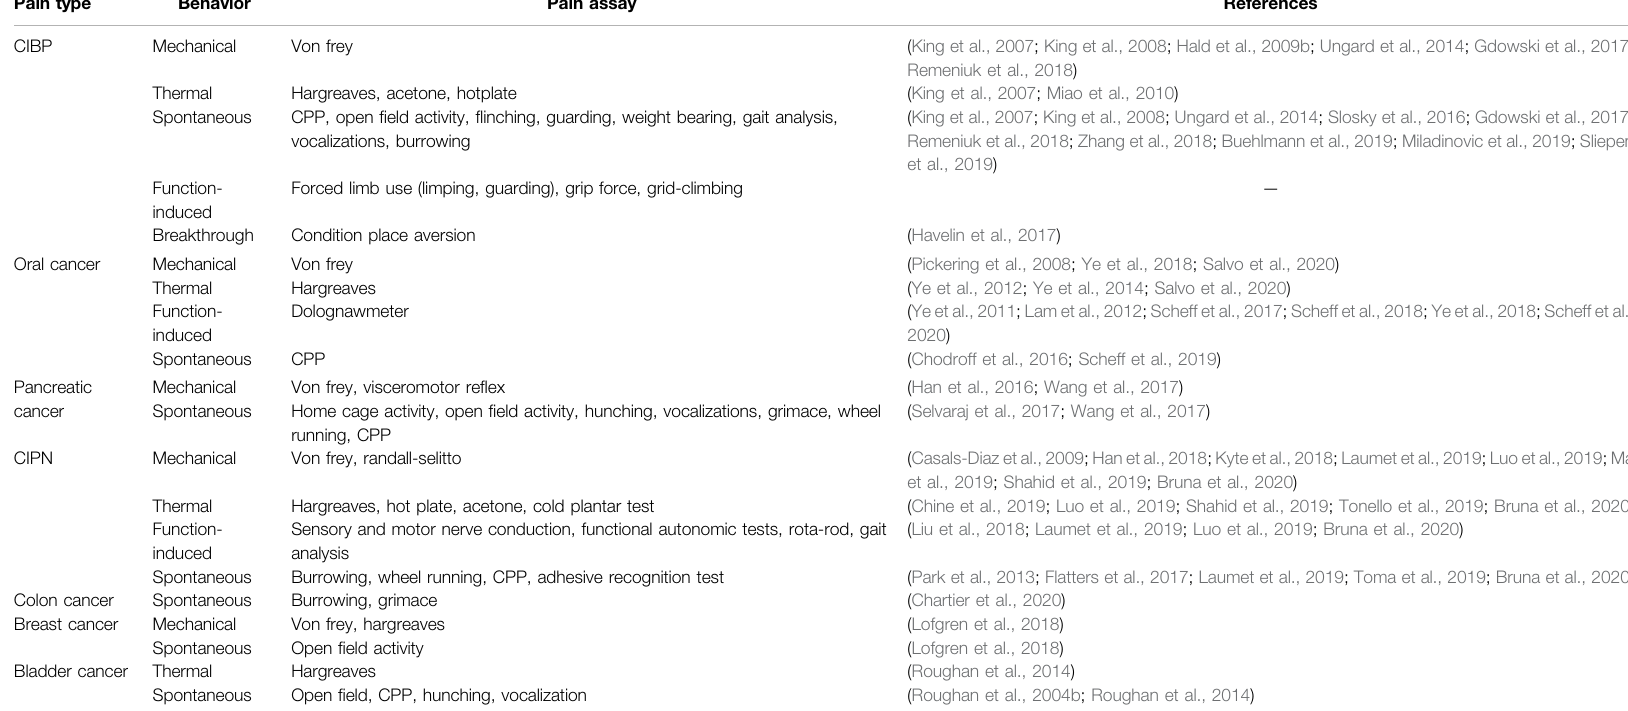
TABLE 2 | Cancer-related nociceptive behavior